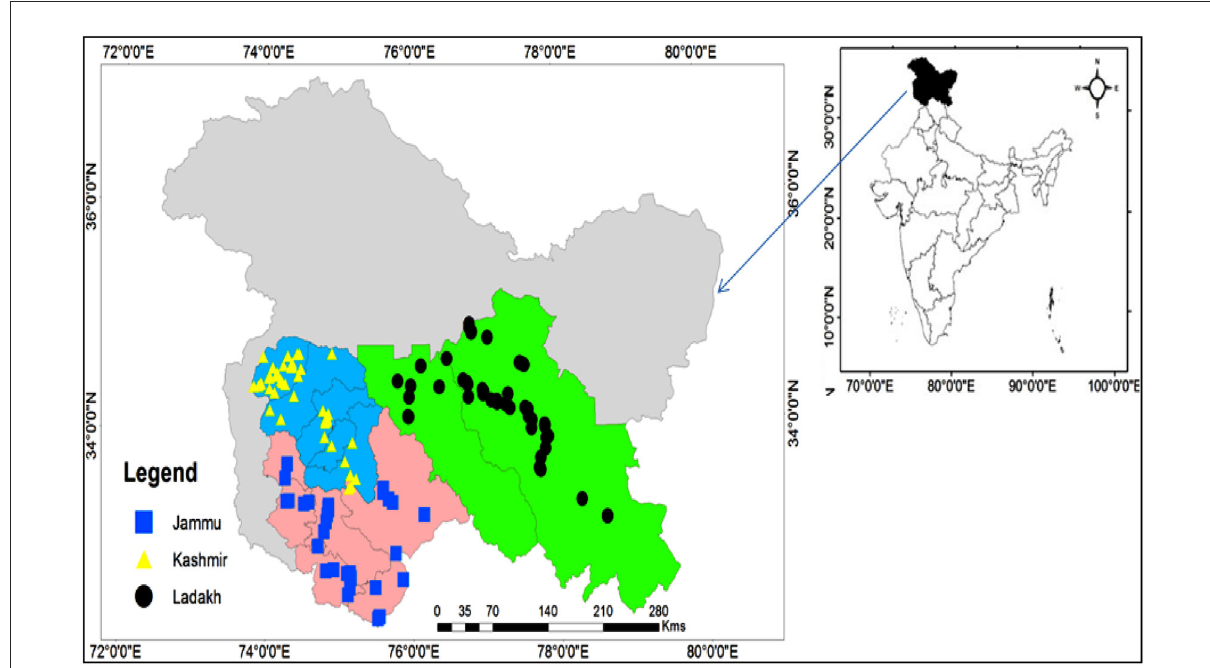
FIGURE1 Map of the Jammu and Kashmir (J&K) and point showing the sampling sites in erstwhile princely state of Jammu and Kashmir. The background colors in the map of different regions were pale yellow color for Ladakh, sky blue color for Kashmir, light pink color for Jammu